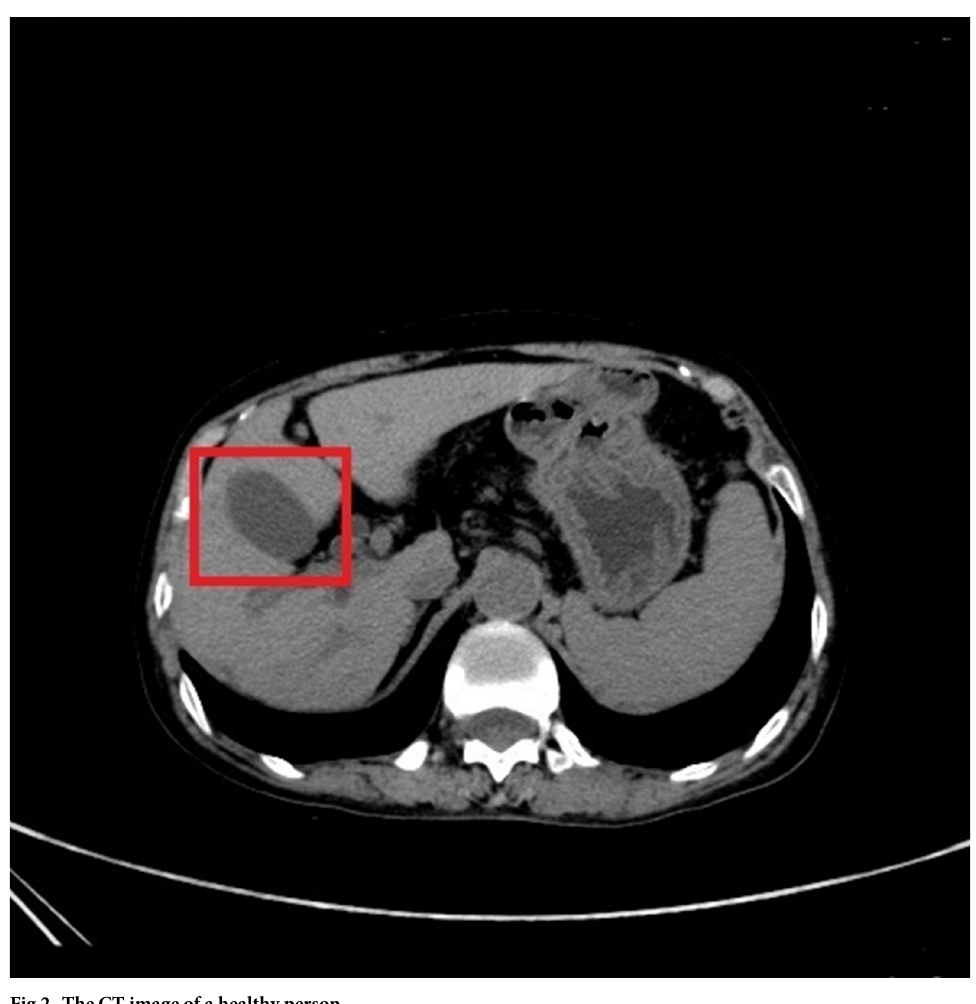
Fig 2. The CT image of a healthy